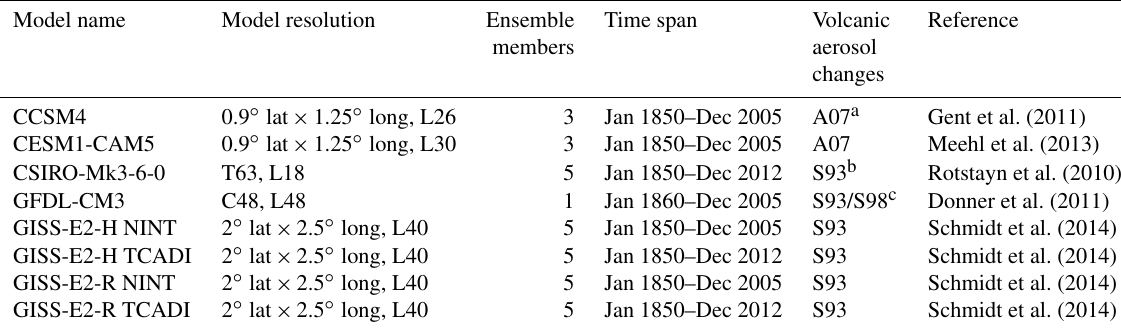
Table 2. CMIP5 models used in this